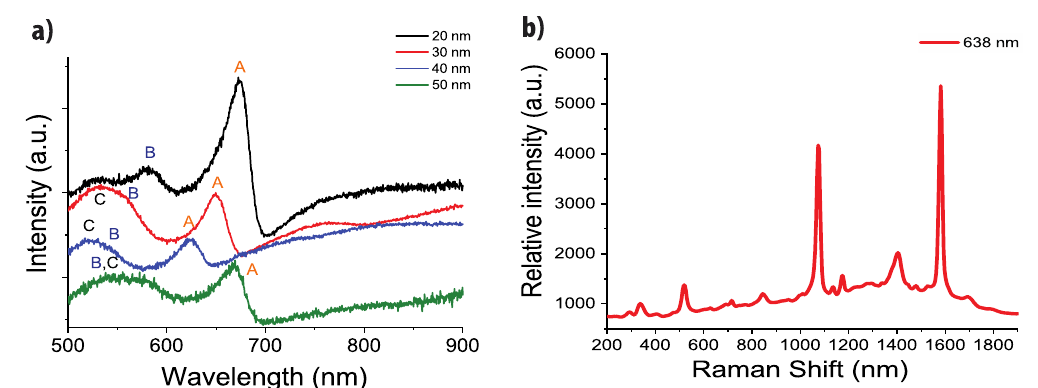
Figure 2. ( a ) Extinction spectra for nanocylinders with a diameter of 250 nm and for different gold film thicknesses (black spectrum: 20 nm, red spectrum: 30 nm, blue spectrum: 40 nm, green spectrum: 50 nm); ( b ) surface enhanced Raman scattering (SERS) spectra of MBA on gold nanocylinders with a diameter of 250 nm and a film thickness of 20 nm. Excitation wavelength: 638 nm.